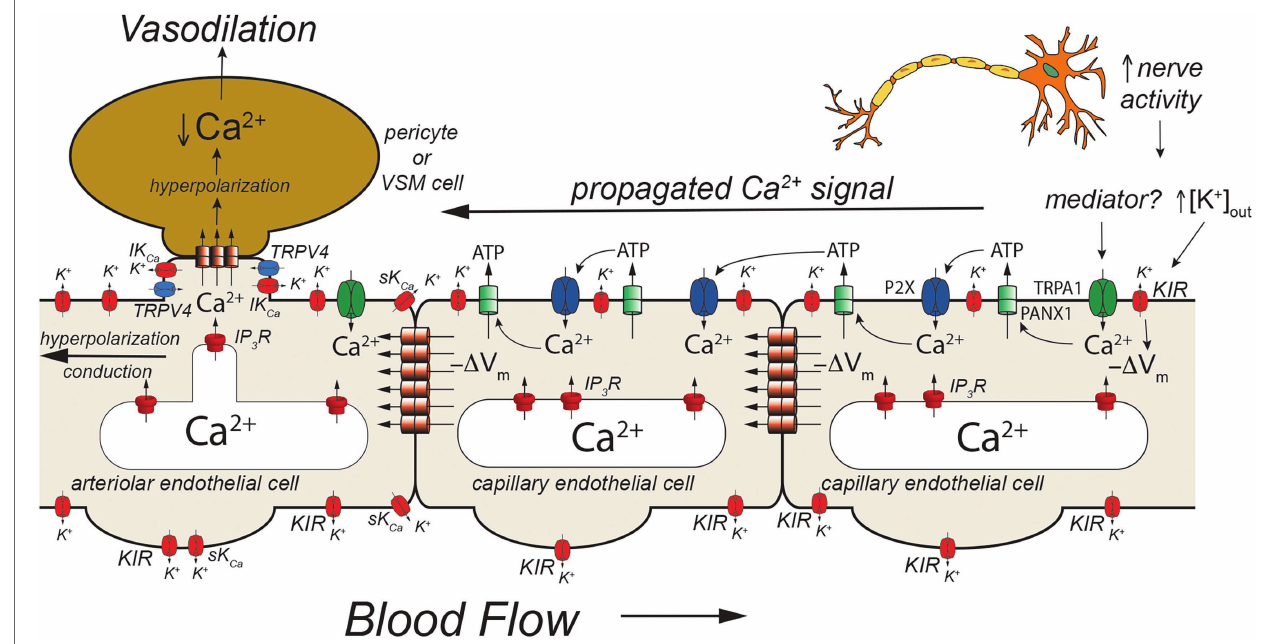
FIGURE 5 | TRPA1- and pannexin-mediated signaling in capillaries. Schematic of a capillary segment that transitions into the initial segment of the capillary coated with contractile pericytes or the terminal arteriole invested with smooth muscle cells. Increased neuron activity leads to increased accumulation of extracellular K + (as in Figures 2 , 3 ) and a yet unidentified mediator. The mediator activates TRPA1 channels in the membrane leading to an increase in [Ca 2+ ] in that then activates adjacent pannexin 1 (PANX1) channels which release ATP into the extracellular space. ATP binds to and activates P 2 X receptors resulting in additional Ca 2+